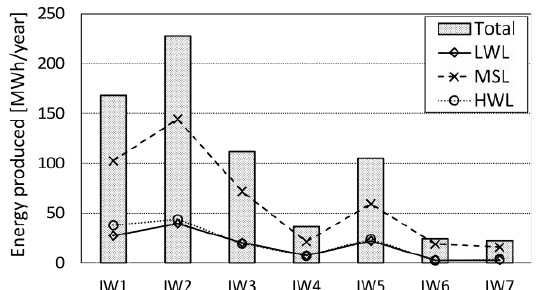
Fig. 16. Energy production of the h-WEC for each water depth and total energy production.